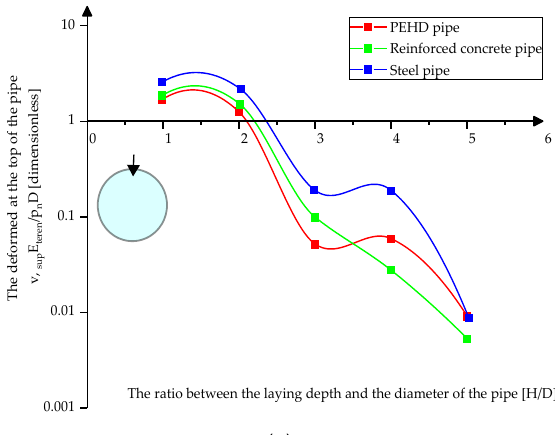
Figure 11. Variation of pressures on pipes in compacted clay ( a ) at the top of the pipes ( b ) at the bottom of the pipes ( c ) in the middle sections.